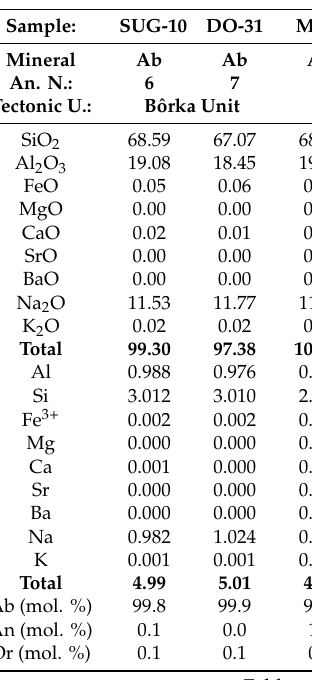
Table 7. Representative analyses of feldspars from the B ô rka, Jaklovce and Meliata